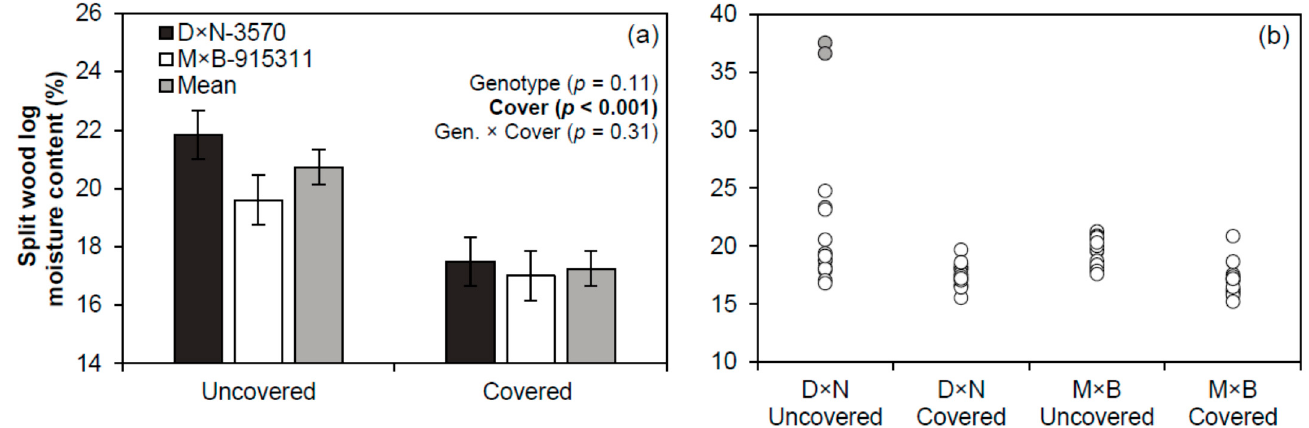
Figure 6. ( a ) Genotype and cover treatment effects on the final moisture content of split hybrid poplar firewood logs (40 cm in length). Vertical bars represent the standard error of the mean; ( b ) Scatter plot of observations for moisture content of firewood logs for the different genotype/treatment combinations, with two outliers being represented by grey circles. For each genotype/treatment combination, 16 logs were sampled on 22 October 2019. Logs were split on 22 May 2019. Initial moisture content of harvested trees was statistically different between the genotypes ( p < 0.001): 57.3 ± 0.3% for genotype D × N-3570 ( n = 20) and 58.9 ± 0.3% for genotype M × B-915311 ( n = 19).